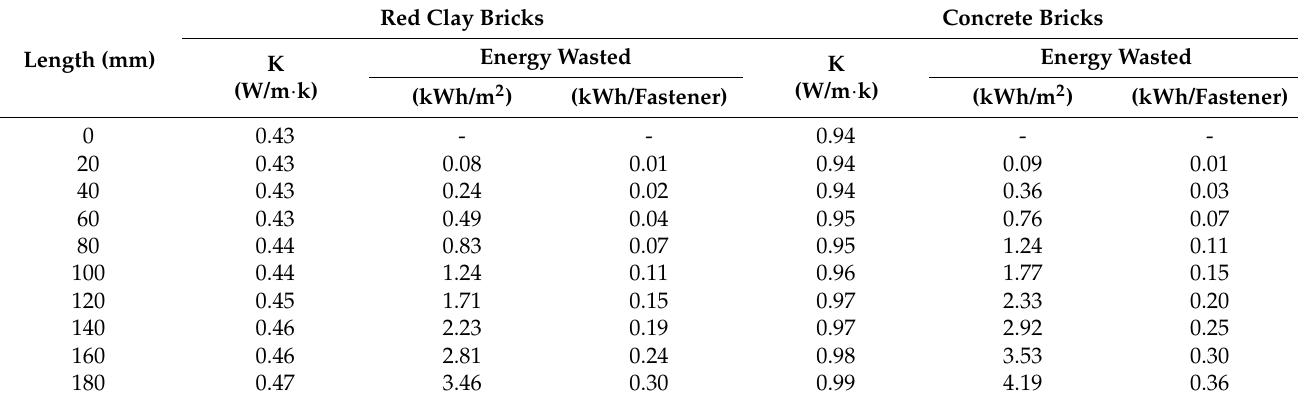
Table 4. Thermal conductivities and energy wasted at different fastener